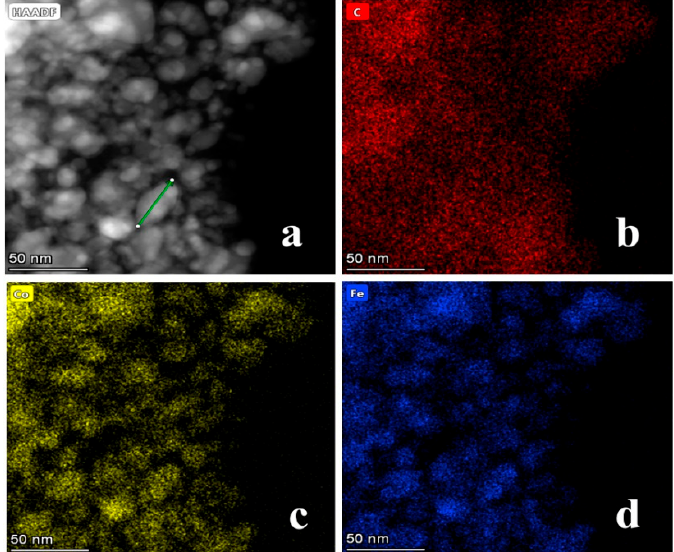
Figure 5. HR-TEM images of ( a ) FeCo/NC-400; ( b ) FeCo/NC-600; and ( c ) EDX spectra of FeCo/NC-600.